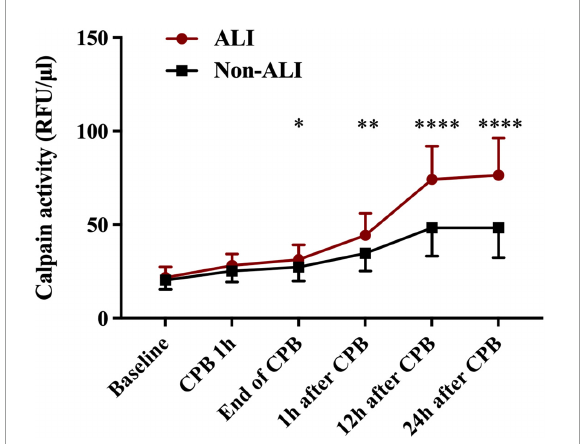
FIGURE1 Mean serum concentration of serum level of calpains at baseline level and different time points perioperative period. (* p < 0.05, ** p < 0.01, and **** p <